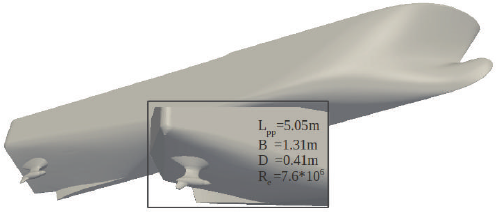
Figure 17: Details of the computational grid in the aft ship region with the local refinements in the propeller